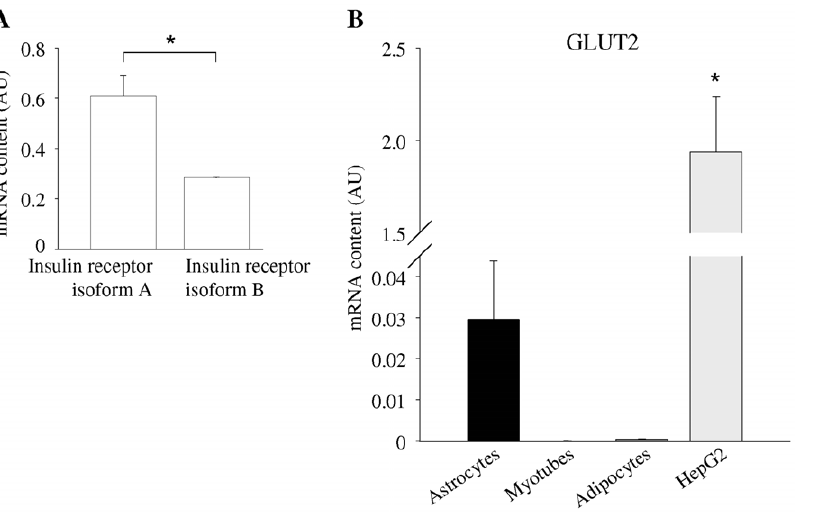
Figure 2. mRNA expression of insulin receptor isoforms A and B as well as GLUT 2 in human astrocytes. ( A ) mRNA expression of insulin receptor isoform A and B in human astrocytes. Given are means + SEM, N=3. * = there were significant differences between groups (Student’s t-test, p=0.0181). ( B ) mRNA expression of GLUT2 in human astrocytes (black bar), human myotubes (white bar), human adipocytes (dark grey bar), and HepG2 (human hepatocellular carcinoma cell line, light grey bar). mRNA expression was normalized for mRNA of the housekeeping gene Rps13 . Bars represent means + SEM. N=3. There were significant differences between the groups (ANOVA, p=0.0006). * indicates significant difference from astrocytes (Tukey Kramer post hoc test p , 0.05).